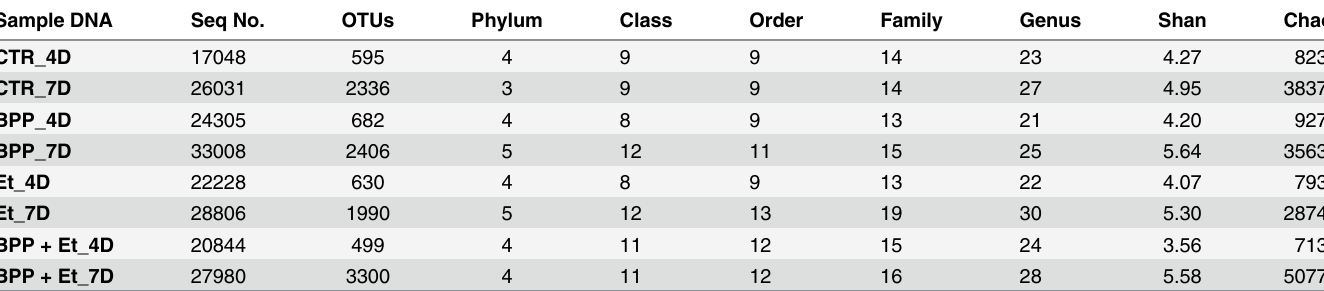
Table 2. Number of sequences, OTUs, classification and diversity indexes for each sample. Sample DNA Seq